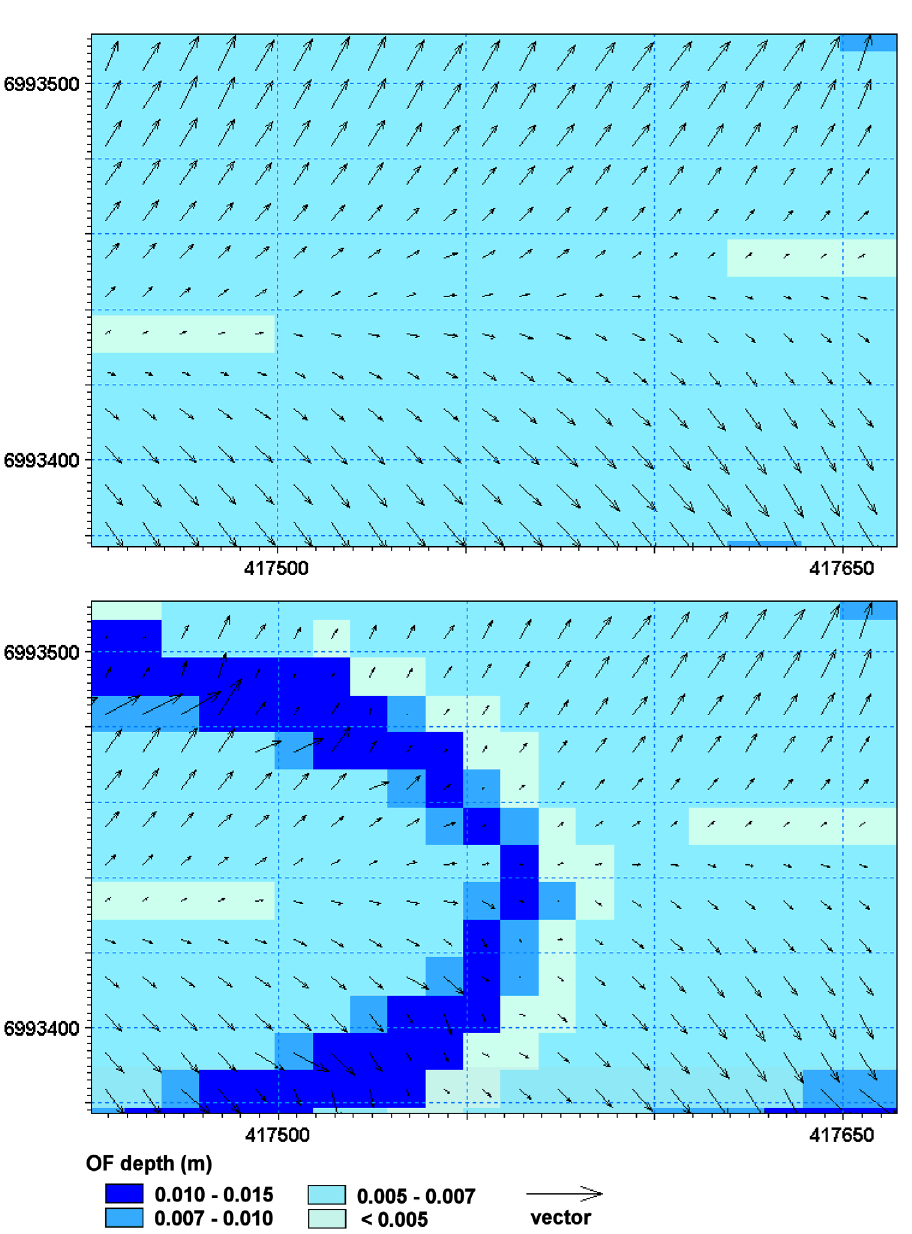
Figure 5. Raster model showing OF distribution between pasture ( top ) and IVB ( bottom ) simulations. The direction and velocity are related to vector orientation and length respectively. Note the significant reduction in overland flow depth beneath the IVB, and the slight redistribution toward the central ridge compared to the pasture